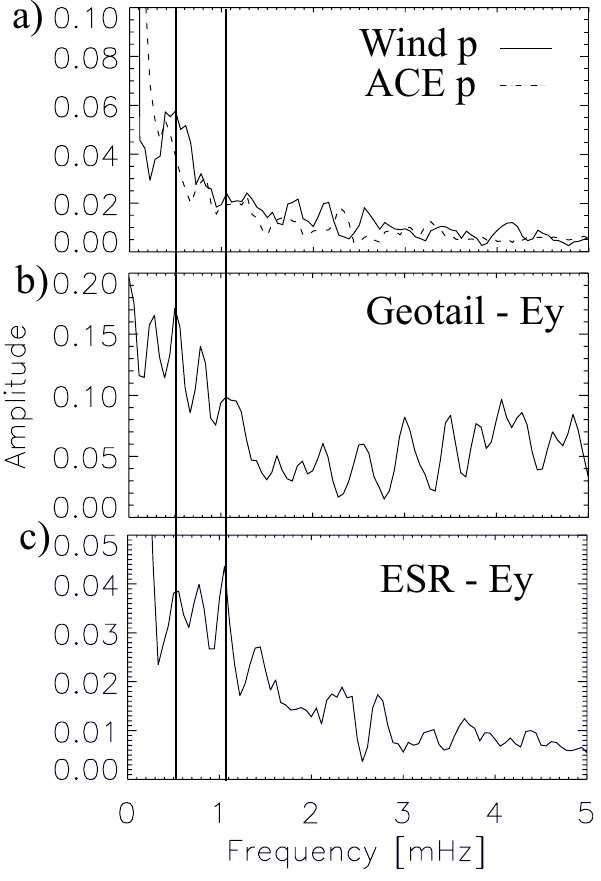
Fig. 13. Average power spectrum over the time interval 17:00– 22:00 UT, 7 December 2000, of ( a ) the solar wind pressure, ( b ) duskward electric field measured by Geotail and ( c ) reconnection electric field measured by ESR. Vertical lines mark the cavity mode at 1 mHz and the solar wind pressure variations at